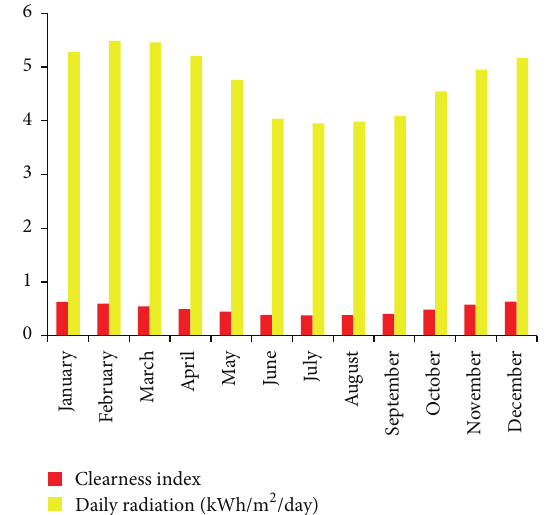
Figure 2: Station graphic display for solar radiation of Ikorodu, Lagos [7].